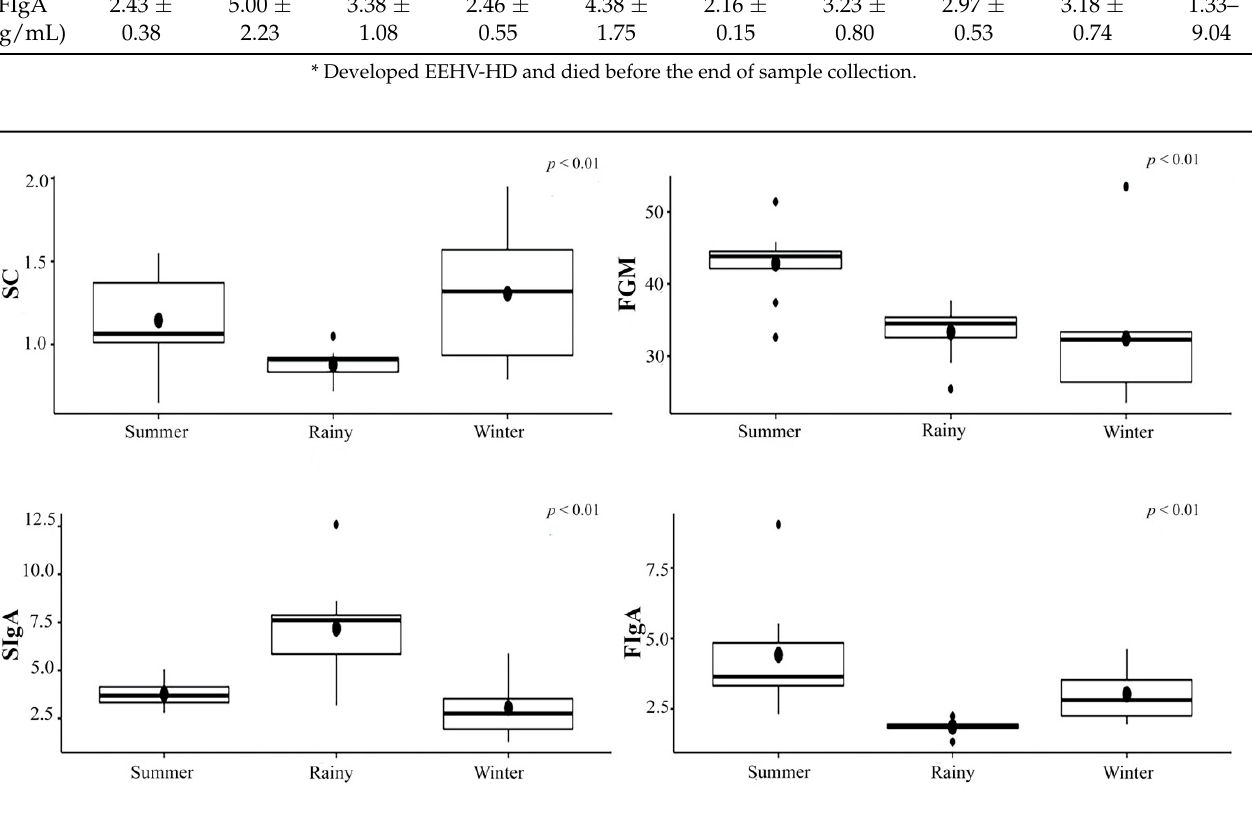
Figure 5. Boxplot presented concentrations of salivary cortisol (SC), fecal glucocorticoid metabolites (FGM), salivary IgA (SIgA), and fecal IgA (FIgA) categorized by EEHV status (non-EEHV or prior-EEHV), excluding E5 that developed EEHV- HD and died during the study.